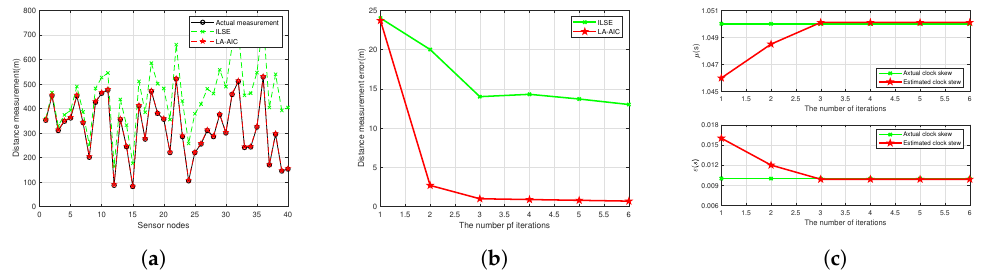
Figure 12. Simulation of LA-AIC (second scenario). ( a ) Real distance and measured distance. ( b ) Ranging error. ( c ) Estimation of clock information.